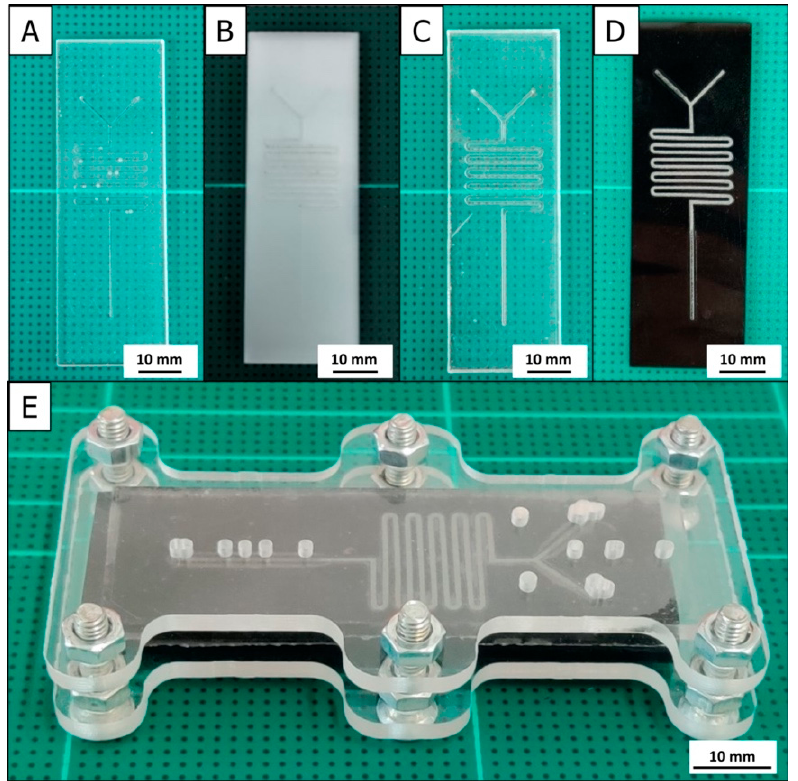
Figure 2. Photographs of a 3D FDM-printed polydimethylsiloxane (PDMS) ( A ), a D-CNC-milled white PMMA ( B ), a M-CNC-molded PDMS ( C ), and a laser-engraved microfluidic black PMMA chip plate ( D ) all with serpentine flow channel integration. Shown in ( E ) is the assembly of a chip plate, here a laser-engraved PMMA microchannel chip plate with a PDMS lid plate in an adapted plate holder.